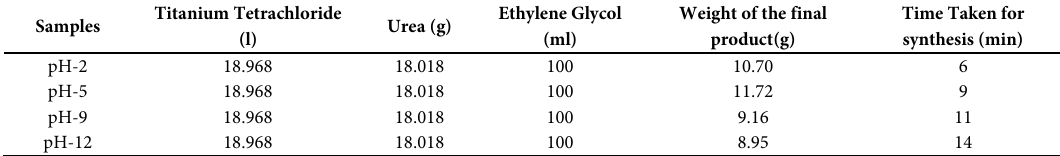
Time Taken for synthesis (min)